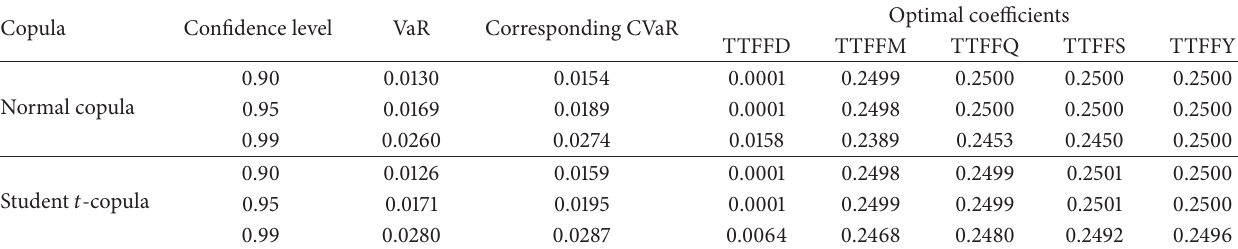
Optimal coefficients TTFFD TTFFM TTFFQ TTFFS TTFFY